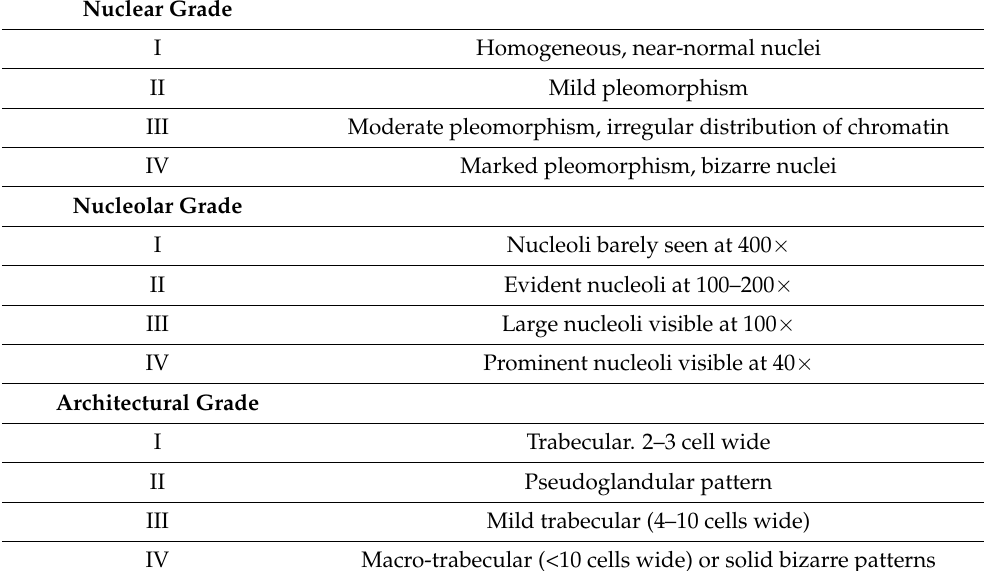
Table 1. Histological grading system applied as proposed by Martins-Filho et al, 2017 [4].